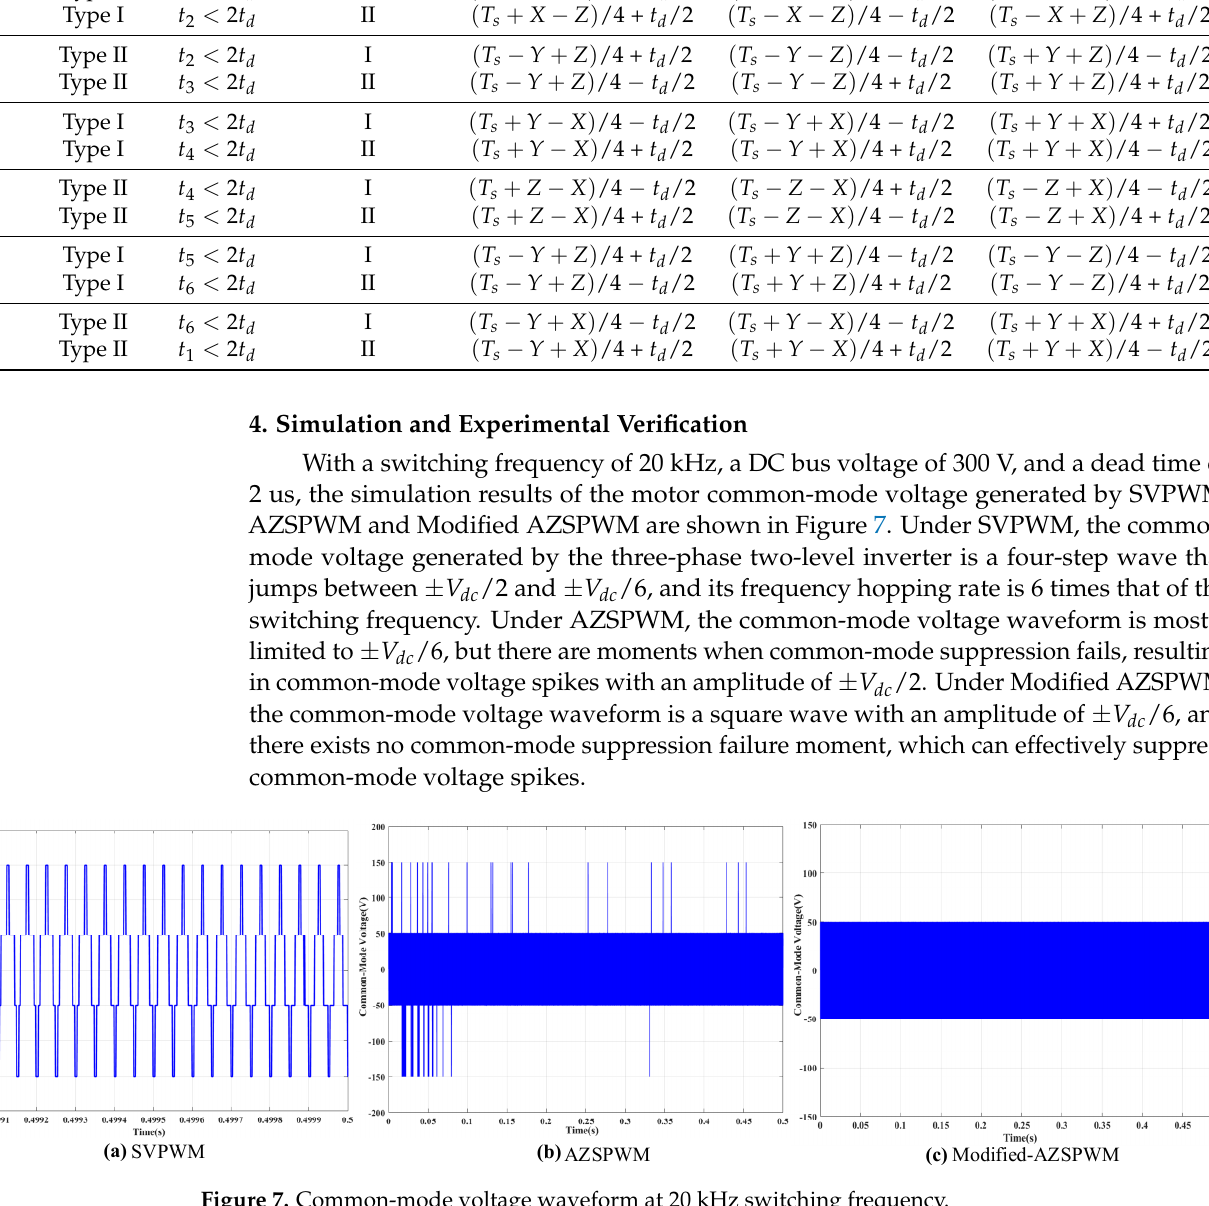
Figure 7. Common-mode voltage waveform at 20 kHz switching Figure 7. Co mmon ‐ mode voltage waveform at 20 kHz switching frequency . The experiment platform was a 7.5 KW permanent magnet synchronous motor drag platform, which is driven by Cree CCS050M12CM2 Silicon Carbide full ‐ bridge module. Drive circuit adopted CGD15FB45P1, and the controller was TMS320F28335 control chip produced by TI company. Current sampling adopted Hall Current Sensor HNC ‐ 50LT for measurement. The measuring instruments were CYBERTEK DP6150B and Tektronix MDO34 digital oscilloscope, as shown in Figure 8. In order to facilitate the measurement, the common ‐ mode voltage was indirectly measured by measuring the three ‐ phase termi ‐ nal voltage of the motor. Under SVPWM, AZSPWM, and Modified AZSPWM modula ‐ tion, the three ‐ phase terminal voltage waveforms of the motor are shown in Figures 9–11.